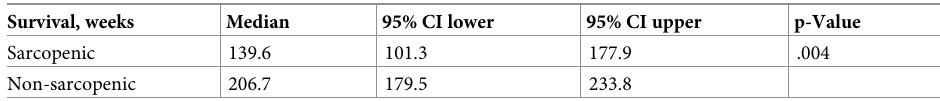
Table 3. Survival; sarcopenic vs. non-sarcopenic patients; Log-Rank test. Survival, weeks